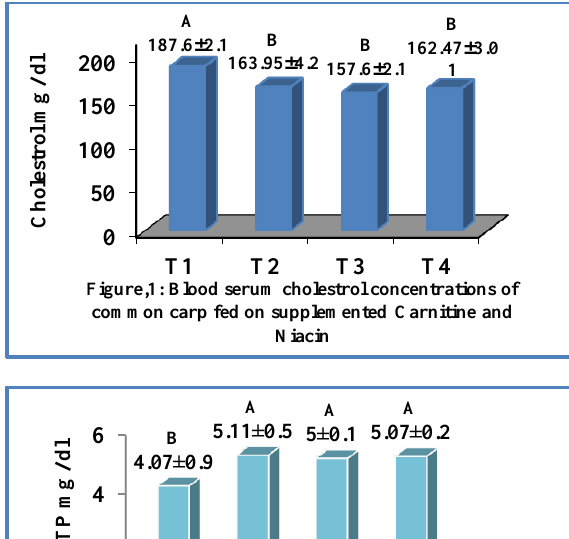
Figure, 2: Serum total protein concentrations of common carp fed on supplemented Carnitine